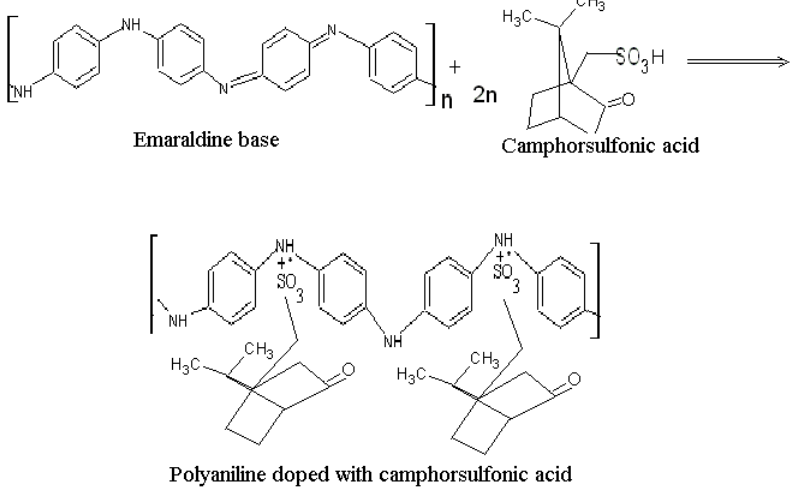
Figure 1. Proposed mechanism for chemical polymerization of Pani doped with camphorsulfonic acid (adapted from 13